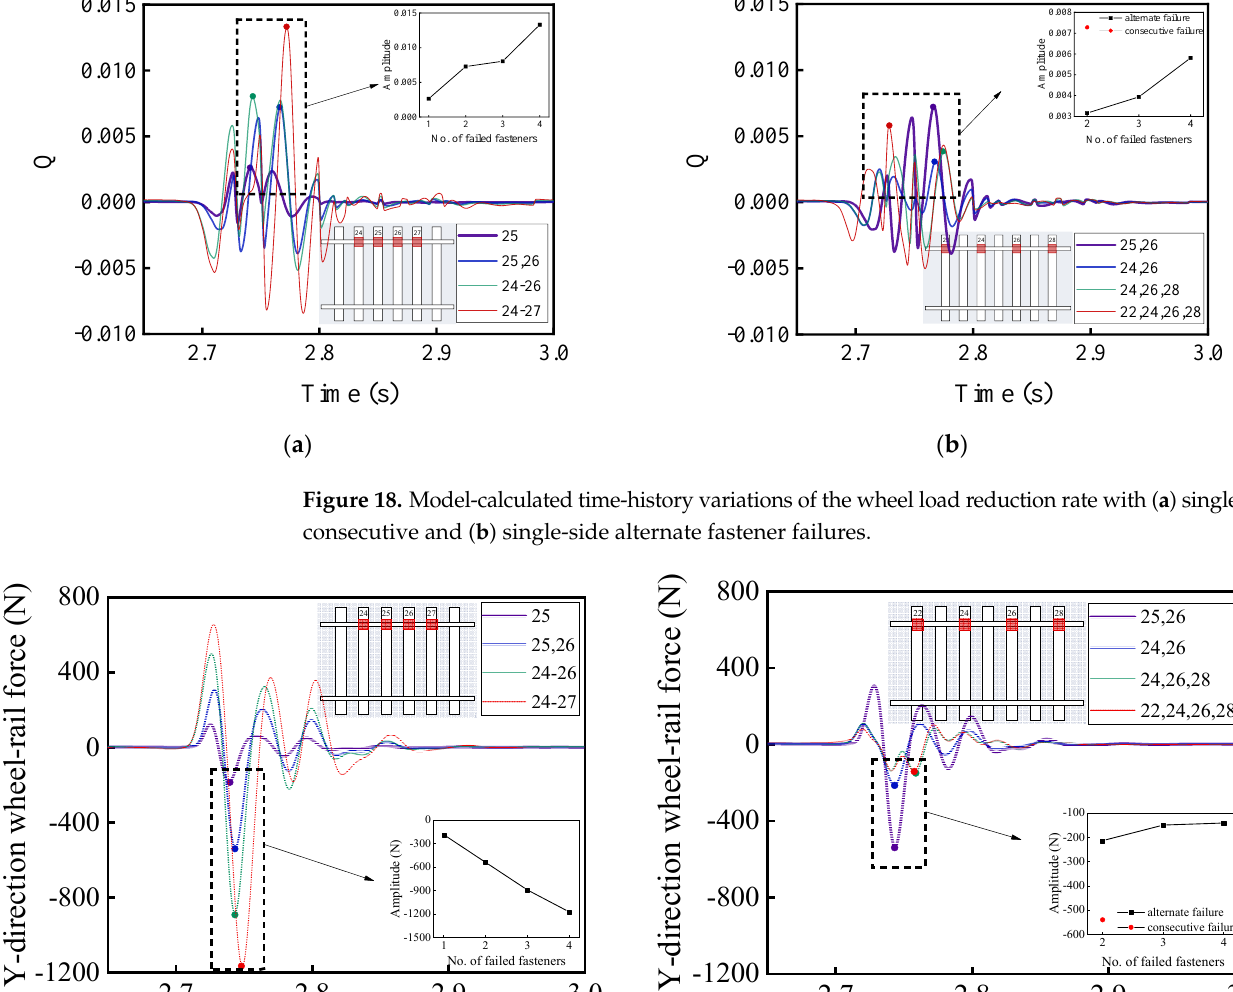
Figure 17. Model-calculated time history curves of lateral (Y-direction) acceleration response of car bodies with ( a ) single-side consecutive and ( b ) single-side alternate fastener failures.